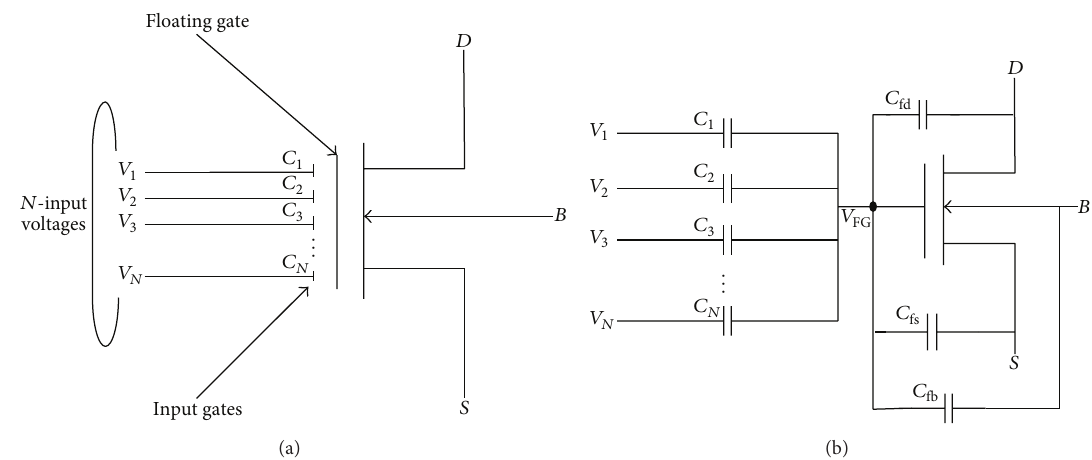
Figure 2: The symbol (a) and equivalent circuit model (b) of N-type 𝑁 inputs FGMOSFET